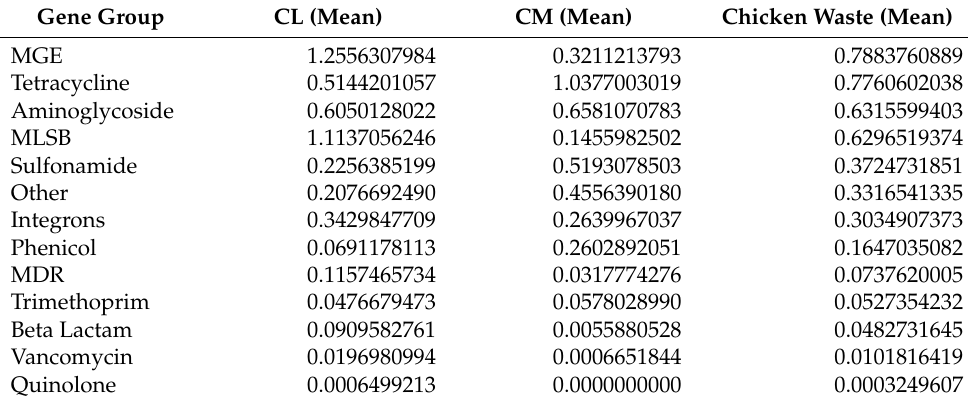
Table 5. The ARGs found in the two studied types of chicken waste (CL and CM), expressed as relative abundance; values for CM and CL are presented as mean values; relative gene abundance is calculated per 16S rRNA gene copies. The data are sorted from most to least